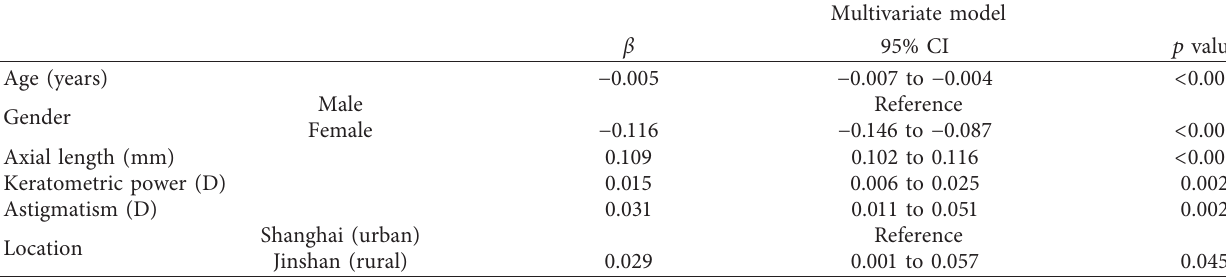
Table 5: Associations of ACD with systemic and ocular factors.